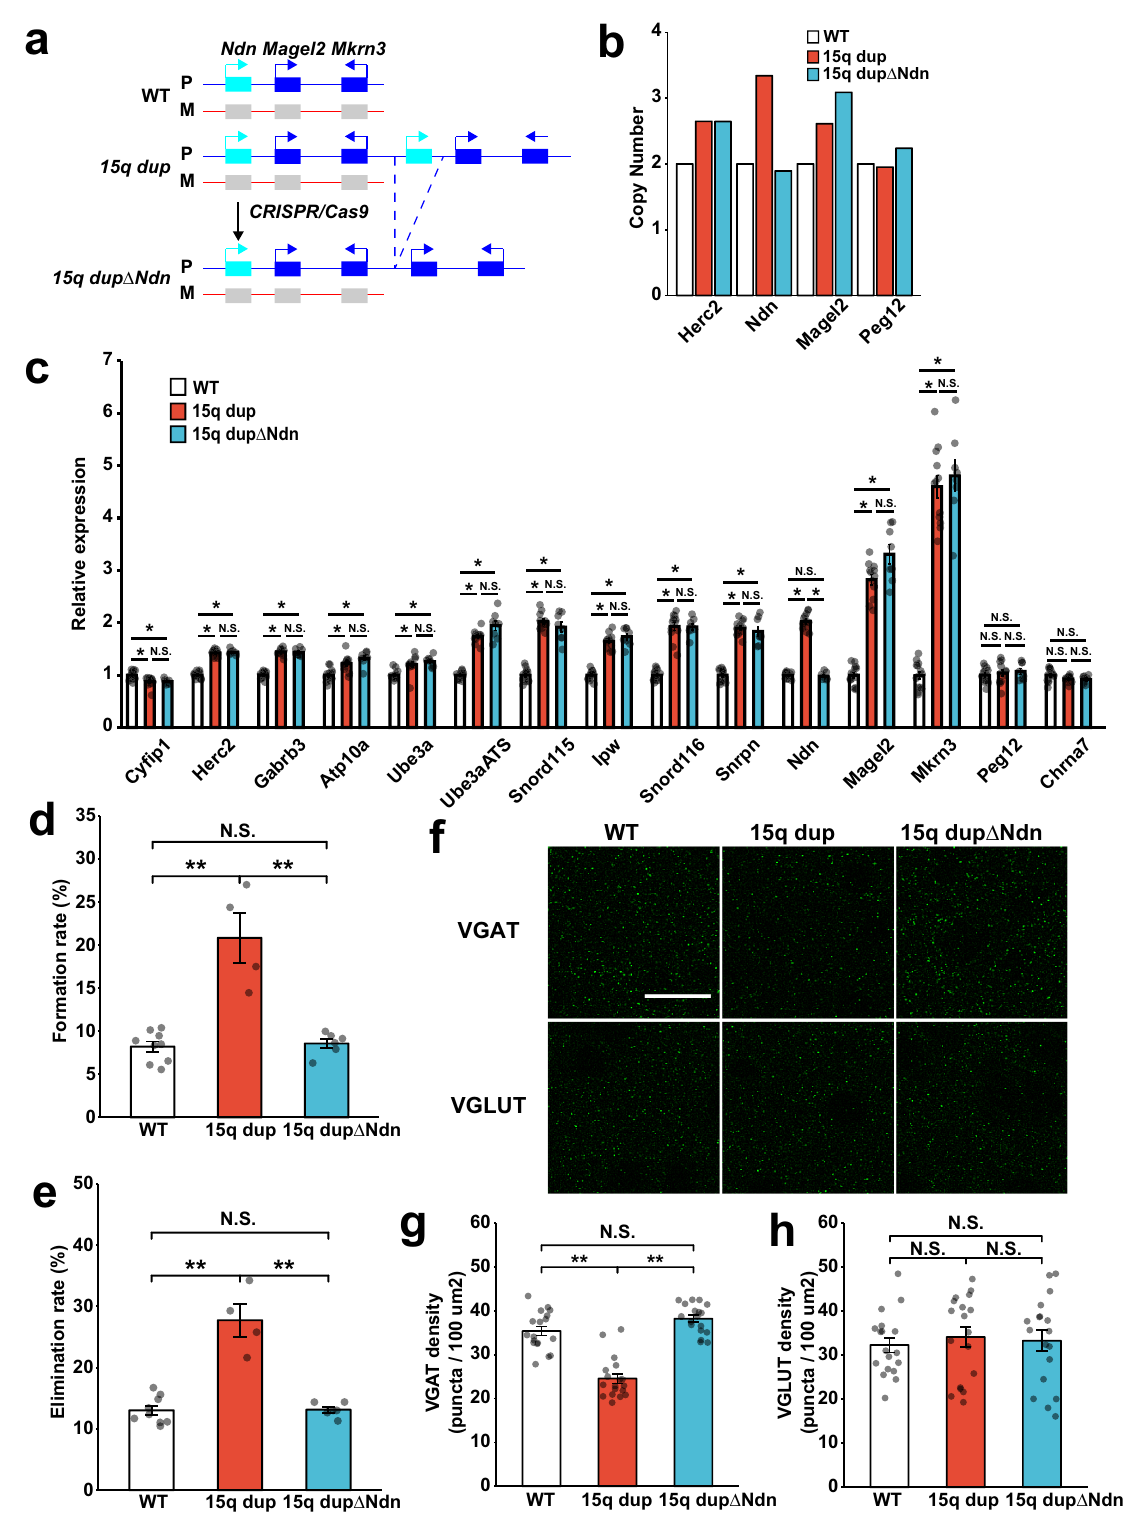
(Supplementary Fig. 7c – e). By genomic PCR and Southern blot, Herc2 and Magel2 , showed around three copies both in 15q dup we could not distinguish a 1 or 2 copy deletion from 15q dup and 15q dup Δ Ndn mice (Fig. 5b). Moreover, we compared the mice having three copies of Ndn . To clarify the exact genomic gene expression level in the brain of paternal 15q dup Δ Ndn mice copy number of Ndn in the target mice, we performed droplet and found that the expression level of Ndn was also normalized to digital PCR (ddPCR) with genomic DNA. The copy number of that of WT mice (Fig. 5c). Taken together, these fi ndings indi- Ndn in 15q dup Δ Ndn mice was comparable to that of WT mice cated that we succeeded in generating 15q dup Δ Ndn mice that (two copies), while other genes included in a duplicated allele, contained a normalized genomic copy number and gene NATURE COMMUNICATIONS| (2021) 12:4056